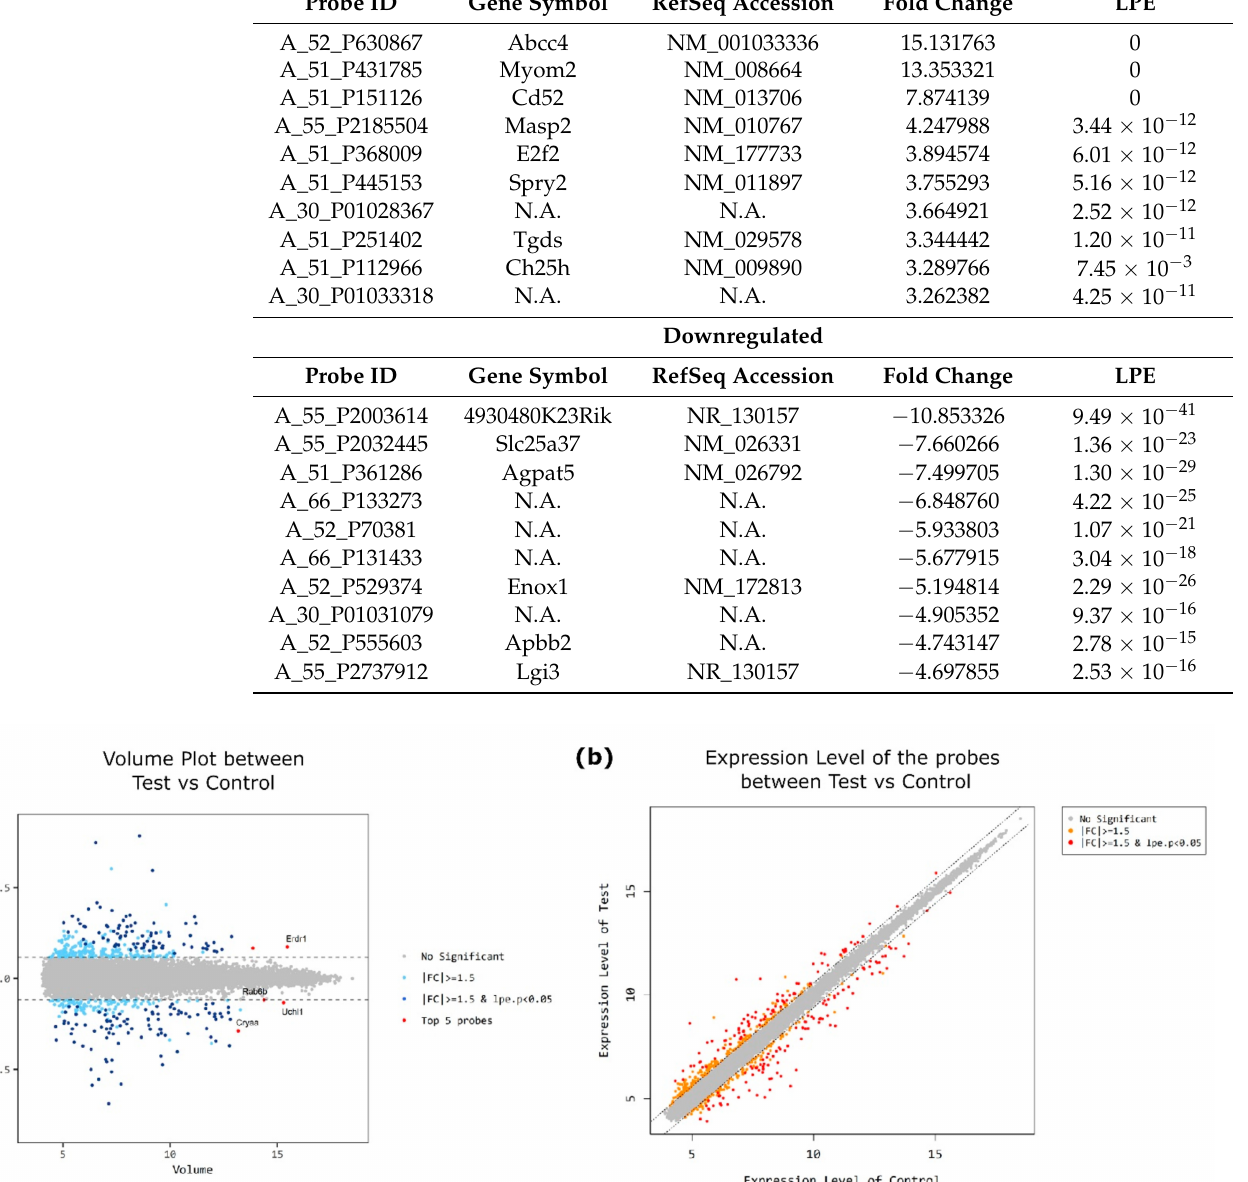
Figure 1. Volume and scatter plots of the normalized microarray data. ( a ) Volume plot. ( b ) Scatter plot. Test, Mrp4-null mice; control, wild-type mice; fc, fold change; lpe, local pooled